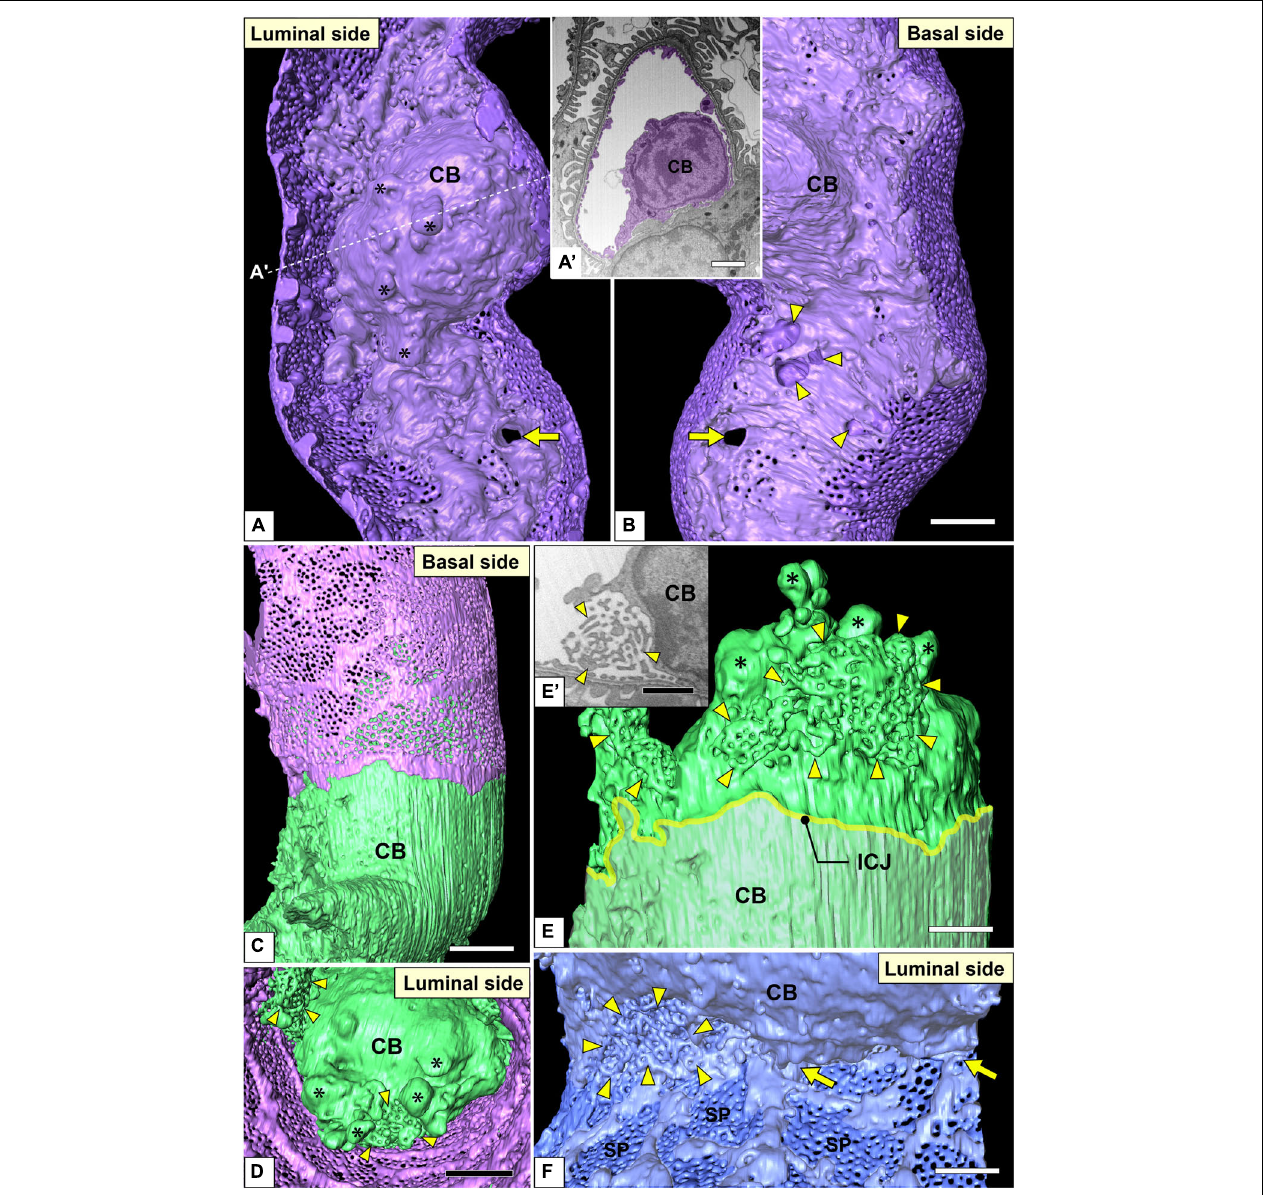
FIGURE 7 | Juxtamesangial region and cell bodies of glomerular endothelial cells (GEnCs). Luminal (A) and basal (B) views of the same juxtamesangial region. The globular protrusions (asterisks) are found on the luminal surface of the cell body. The non-adhesive mesangial cell processes create the perforation (arrow) and indentations (arrowheads) at the juxtamesangial region. (A (cid:48) ) The sectional focused-ion beam-scanning electron microscopy (FIB-SEM) image at the dotted line in (A) . (C–E) Cell body of the green GEnC. This cell body possesses reticular porous structures (arrowheads in D,E ), in addition to globular protrusions (asterisks in D,E ), on the luminal surface. (E) The purple GEnC is removed from (C) to show the luminal surface of the green GEnC. (E (cid:48) ) FIB-SEM image of the reticular porous structure shown in (E) . (F) Luminal view of the connecting part of urinary and juxtamesangial regions. The intersieve ridges continue the cell body (arrows), and the reticular porous structure (arrowheads) exists at the angle between urinary and juxtamesangial regions. ICJ, intercellular junction between green and purple GEnCs; CB, cell body of GEnC; SP, sieve plate. Scale bar, 5 µ m in (A (cid:48) ,B,D) ; 2 µ m in (E,F) ; 100 nm in (E (cid:48) ) . The reconstructed image of GEnC (A,B) is also shown in Supplementary Movie 7